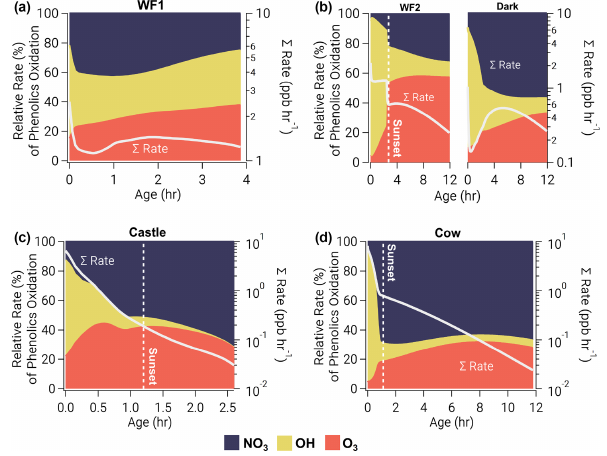
Figure 7. Relative oxidation rate (left axis) of phenolics by NO 3 (blue, top), OH (yellow, middle), and O 3 (orange, bottom) for all model runs as a function of plume age. Right axis shows absolute total reactivity (white line) on a log scale. Phenolic oxidation is con- trolled by OH at emission but eventually transitions to NO 3 oxida- tion before sunset in the WF1, Castle, and Cow model runs or after sunset in the WF2 model run. Even without photolysis, OH oxida- tion dominates phenolic oxidation early in the Dark model run.